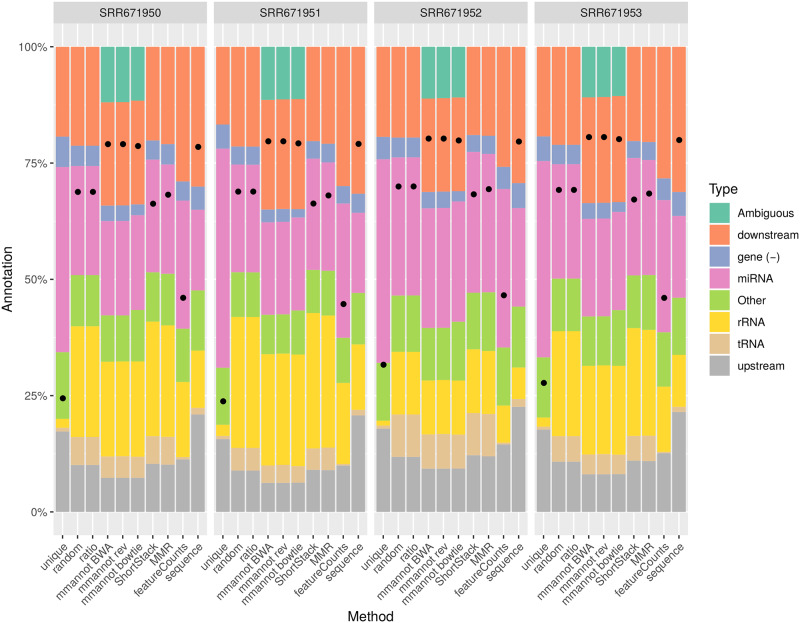
Comparison of the different strategies on the A. thaliana data sets.Each chart provides the result on one sequencing data set, using the previous strategies presented before. The “unique” strategy only considers uniquely mapping reads. The “random” strategy chooses arbitrarily a hit for each read. The “ratio” strategy counts 1/n per feature, if a read maps n times. Our method uses BWA for read mapping, and is named “mmannot BWA”. In the “mmannot rev” lines, the order of the lines of the configuration files are reversed. The “mmannot bowtie” line gives the result of the “mmannot” strategy using bowtie instead of BWA for mapping reads. The “ShortStack”, “MMR”, and “featureCounts” columns gives the annotation results, based on their strategies. Last, we mapped the reads to sequences of sRNAs (instead of the genome), and provided the results in the “sequence” bars. Each column provides the percentage of reads, classified by annotation. The ambiguous category includes hits that overlap several annotations. sRNAs with low counts were grouped into the category “other”. The dots in the bars provide the percentages of the reads that where annotated.